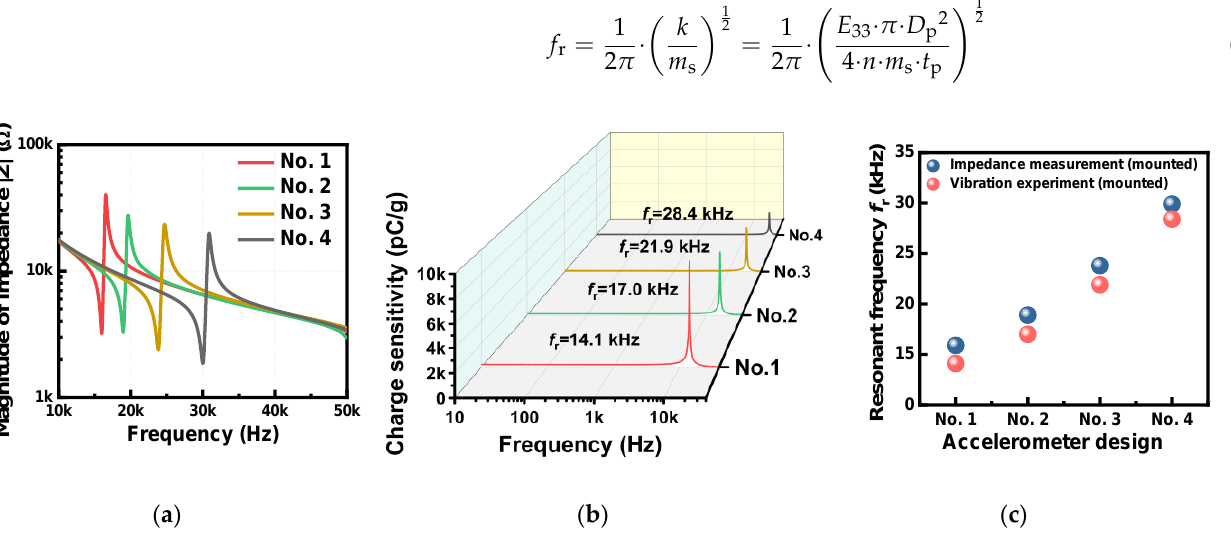
Figure 6. ( a ) Impedance – frequency spectra measured from impedance measurements for accelerometer prototypes in the mounted condition. ( b ) Frequency response profiles measured from vibration experiments in the mounted condition. ( c ) Results of resonant frequency f r determined from both measurements.